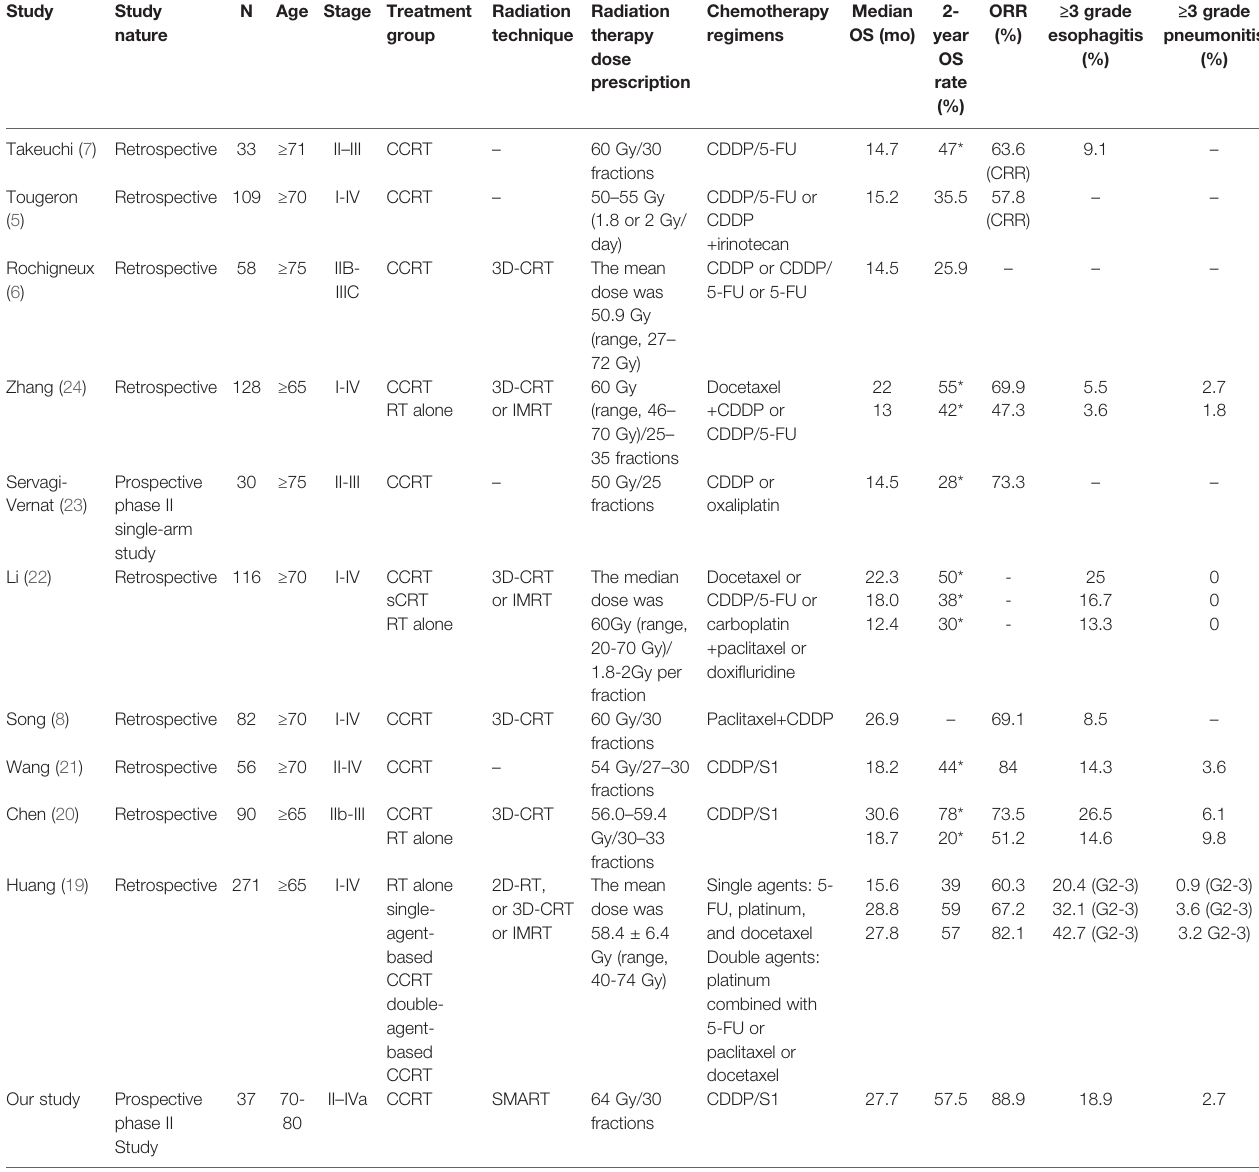
TABLE 6 | Previous studies of radiotherapy for elderly patients with esophageal